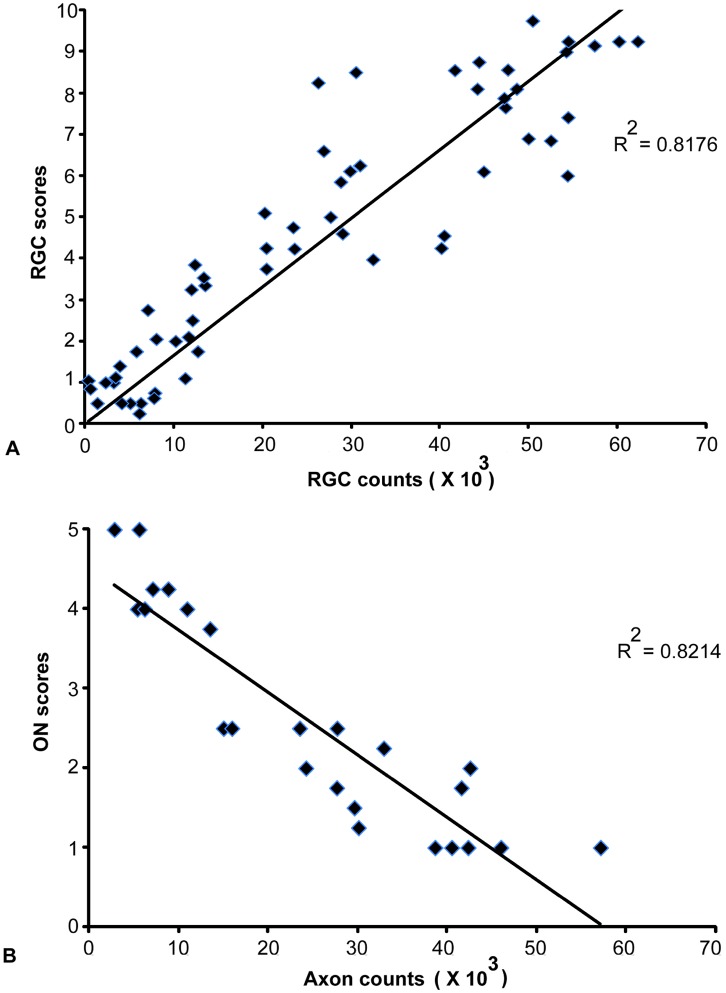
Correlation between semi-quantitative scoring and counting of RGCs (A) and ON axons (B).Linear regression coefficients (R
2) are indicated on the graphs.